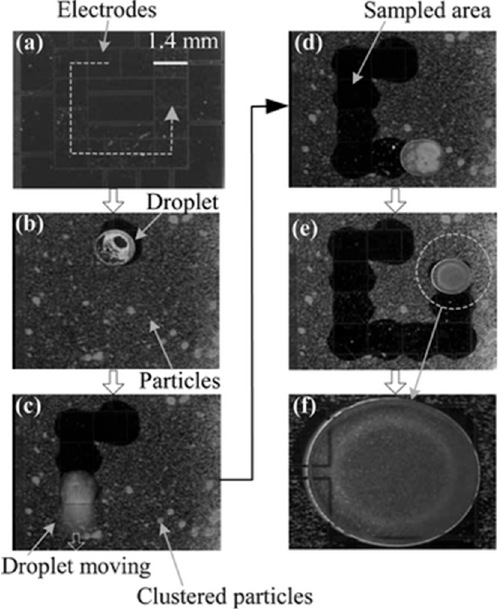
Figure 11. ( a–e ) Glass beads are collected sequentially using water droplets. The glass beads are suspended inside the sweeping water droplets. The dashed line in ( a ) indicates the path of the droplet for particle sampling and cleaning. Reproduced with permission from [134], published by Royal Society of Chemistry, 2006. ( f ) shows a close-up view of the droplet with suspended sampled particles.